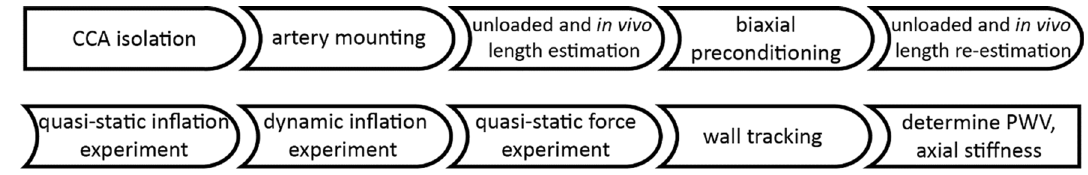
Figure 8. Timeline of experimental protocol. CCA common carotid artery, PWV pulse wave